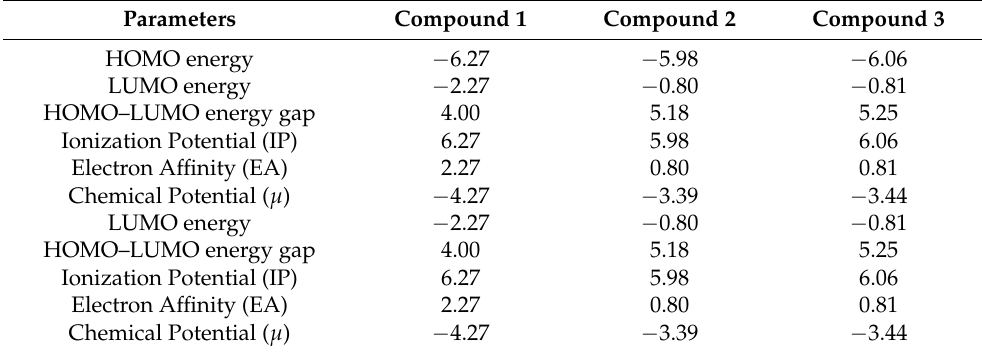
Figure 9. Computed energy levels HOMO–LUMO for compounds ( a ) 1 , ( b ) 2 and ( c ) 3 , using the crystallographic information files (cif) by B3LYP method using the 6-31G(d,p) basis set. Table 4. HOMO and LUMO orbital energies (eV) and global reactivity descriptors (eV) for compounds 1 , 2 and 3